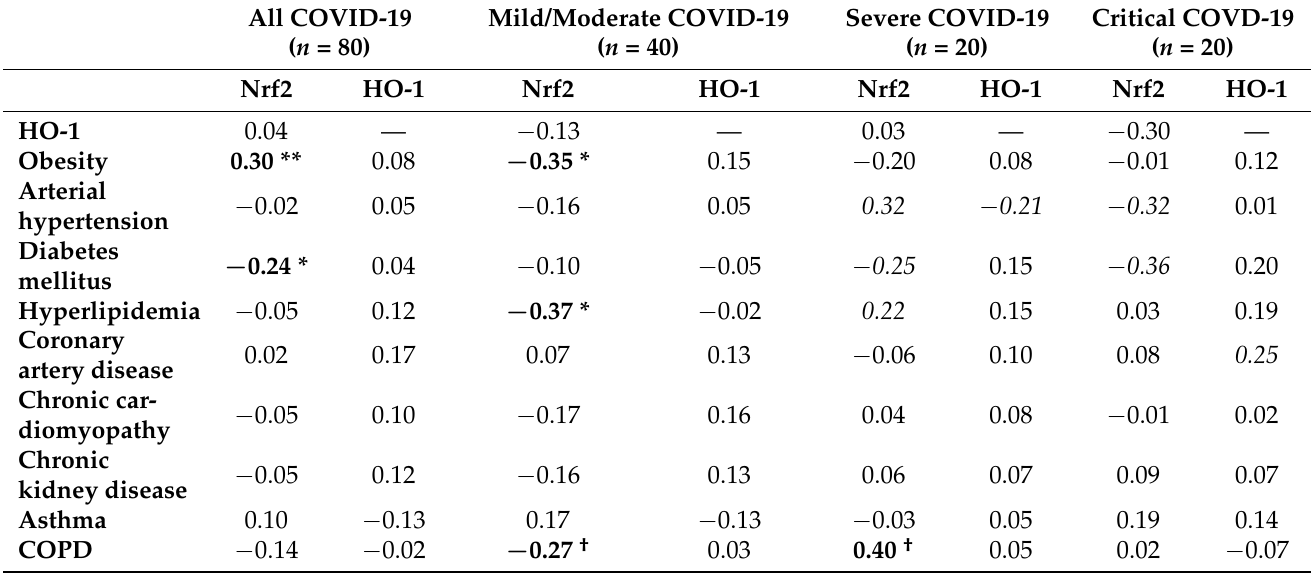
Table 6. Intercorrelations of Nrf2 and HO-1 with comorbidities.